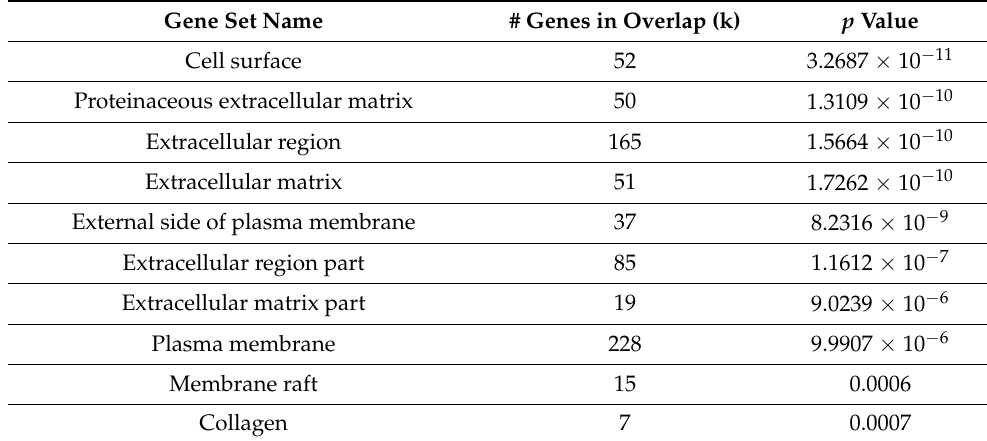
Table 4. Top ten cellular components from Gene Ontology (GO)